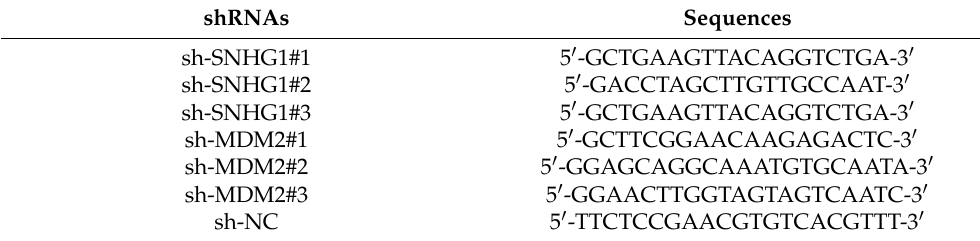
Table 3. sh-RNA sequences for